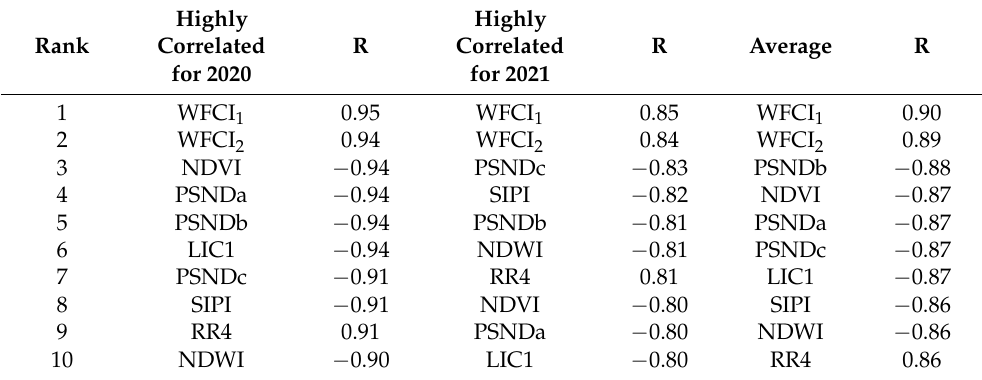
Table 1. The list of the highly correlated top 8 VIs for each wheat season that are calculated through the pooled dataset of 2020 and 2021